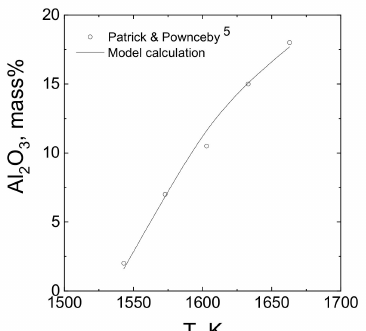
Figure 4. Comparison of the calculated and experimental measured minimum solubility of Al 2 O 3 in SFCA